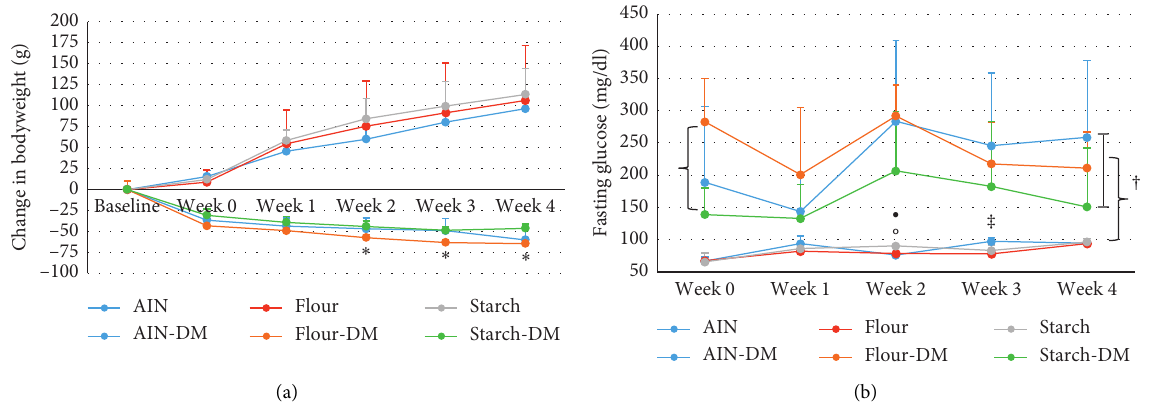
Figure 1: (a) Changes in bodyweight development of the non-DM and DM rats over the 4-week period. (b) Fasting glucose of the non-DM and DM rats over the 4-week